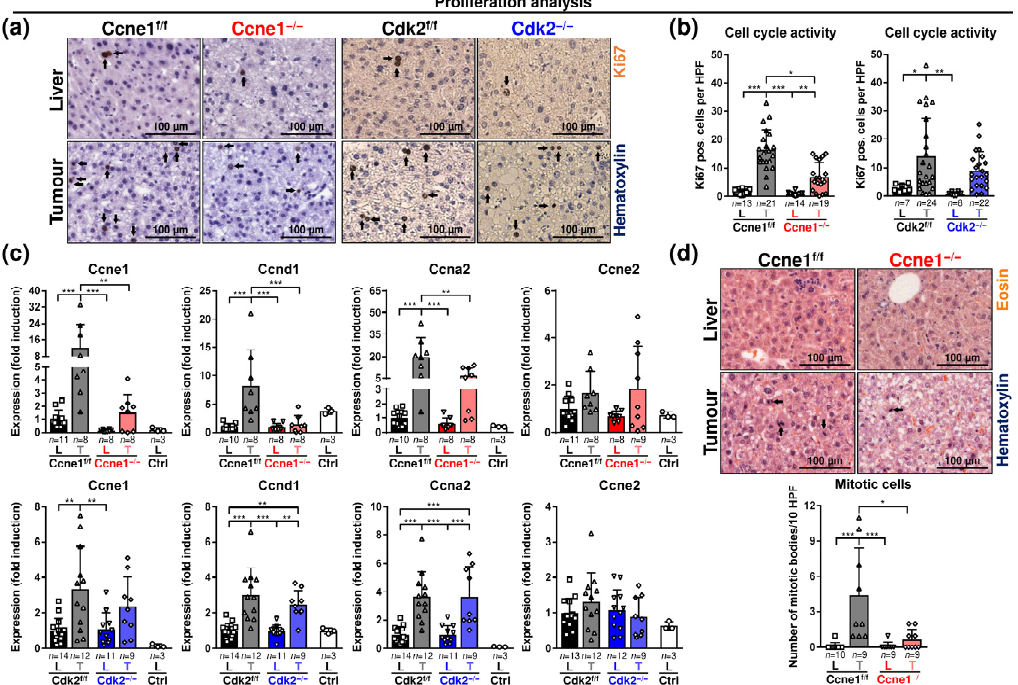
Figure 2. Depletion of Ccne1 during HCC progression limits cell cycle activity. Two-week-old, Mx-Cre transgenic mice with floxed Ccne1 or Cdk2 alleles were treated with DEN. After tumour initiation, mice were repetitively injected with pIpC at week 22 to induce the deletion of Ccne1 or Cdk2 (Ccne1 − / − , Cdk2 − / − ). Mx-Cre -negative mice also received both DEN and pIpC and served as wildtype controls (Ccne1 f/f , Cdk2 f/f ). HCC progression was analysed after week 40. Details are given in Figure 1 and in the method section. L: liver; T: tumour tissue. ( a ) Immunohistochemical staining for Ki67 (brown) in paraffin sections of Ccne1 f/f and Ccne1 − / − (left) or Cdk2 f/f and CDK2 − / − (right) animals. Total nuclei were stained with haematoxylin (blue). Arrows indicate Ki67-positive cells; ( b ) quantification of Ki67-positive cells in non-tumorous liver (L) and tumorous tissues (T) of Ccne1 f/f and Ccne1 − / − (left) or Cdk2 f/f and CDK2 − / − (right) animals; ( c ) gene expression anal- ysis of Ccne1 , Cyclin D1 ( Ccnd1 ), Cyclin A2 ( Ccna2 ) and Cyclin E2 ( Ccne2 ) in Ccne1 f/f and Ccne1 − / − (top) mice or Cdk2 f/f and Cdk2 − / − (bottom) animals. Ctrl: livers of untreated wildtype mice. Normalised expression levels were calculated as fold induction in comparison to DEN-treated control livers. ( d ) Top: mitotic activity in H&E-stained paraffin sections of non- tumorous liver tissues and tumorous tissues of Ccne1 f/f and Ccne1 − / − animals. Arrows indicate mitotic bodies. Bottom: quantification of number of mitotic bodies per 10 HPF at a magnification of 200x. HPF: high power field. Sample sizes are indicated within diagrams. Data are expressed as mean ± SD. *: p < 0.05; **: p < 0.005; ***: p < 0.001. 3.2. Absence of Ccne1 Modifies the DNA Damage Response and Restrains Stemness and Microinvasion during HCC Progression Aberrant hepatic CCNE1 expression induces DNA damage due to replication stress and oxidative stress, which promotes double-strand breaks (DSB), chromosomal instabil- ity and selective hepatocyte transformation in mice [2,8,10]. Hence, we investigated the influence of interventional Ccne1 or Cdk2 depletion in HCC on markers of DNA damage and repair during HCC progression. Phosphorylation of histone H2AX (pH2AX), a marker for DSB, in dissected tumours and corresponding liver tissues was not signifi- cantly different between Ccne1 f/f and Ccne1 − / − mice at week 40 after DEN (Figure 3a,b). We next examined the extent of general DNA damage responses (DDR). DSB or DNA single-strand breaks (SSB) activate the Ataxia telangiectasia mutated/Ataxia telangiectasia and Rad3 related (ATM/ATR) pathway. In HCC, overexpression of CCNE1 is associated with ATR activation and upregulated DNA repair genes [2,8]. Deletion of Ccne1 , but not Cdk2, in advanced liver tumours was associated with reduced phosphorylation of an un- known ATM/ATR substrate of approximately 35 kDa (Figure 3c). In DEN-induced WT HCC, the expression of the DNA mismatch repair gene MutS Homolog 2 ( Msh2 ) and the DSB repair gene Rad51b were significantly induced compared to surrounding liver tissues.